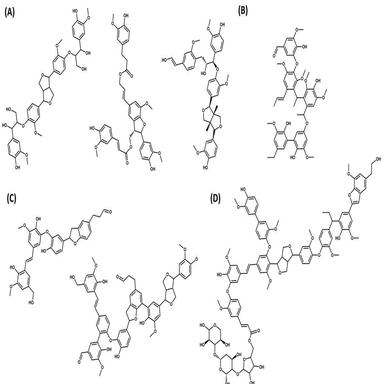
Previously proposed structures of PL oligomers. (A) G-based tetramers from pine sawdust PL (B) Pentamer from red oak PL (C) Oligomers from beech wood PL (D) Oligomer from switchgrass PL.